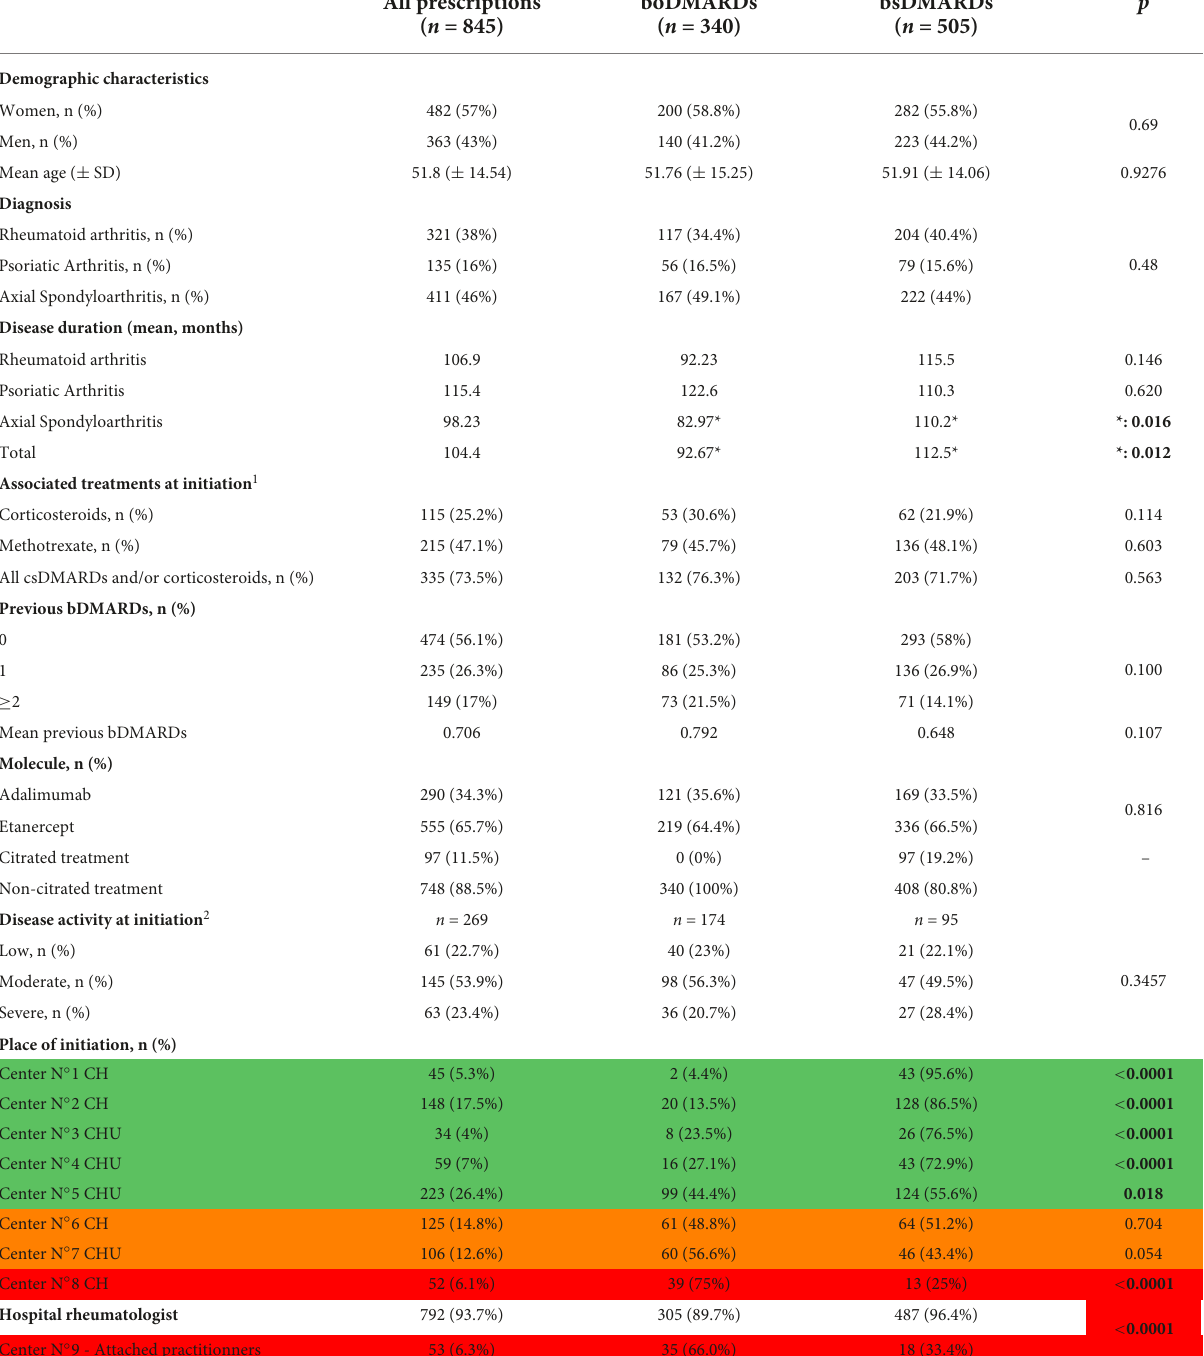
TABLE 1 Detailed characteristics of all 845